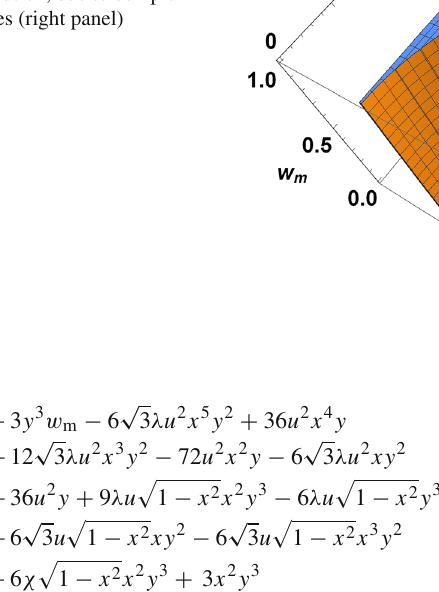
Fig. 1 a The case where the critical point O represents a stable cosmological scenario (left panel), b the situation where O corresponds to a stable spiral evolution, due to complex eigenvalues (right